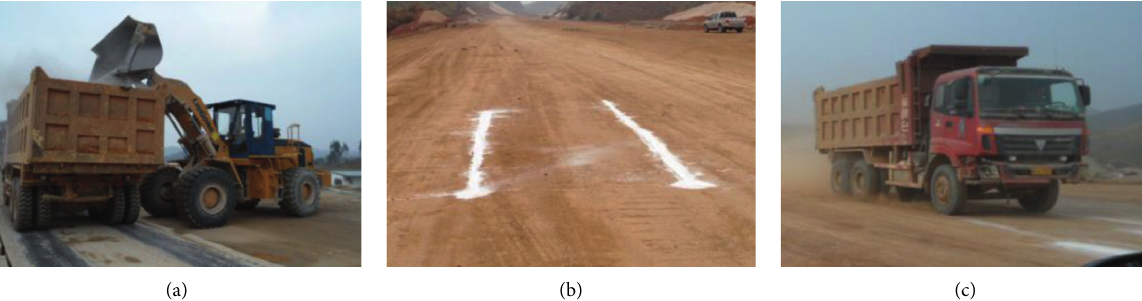
Figure 5: Preparation and testing process: (a) truck rear axle weighing, (b) marked position of the sensor, and (c) the truck passing over the